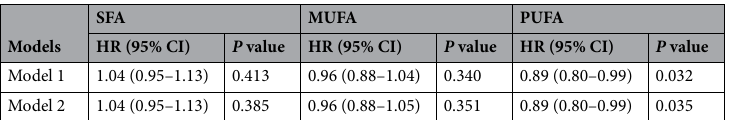
Table 4. A 5% higher calorie intake from usual intake of fatty acids and heart disease mortality risk with further adjustment for LDL cholesterol, HDL cholesterol, and triglyceride among 44,279 adults without a prior diagnosis of MI. Model 1: adjusted for age, sex, ethnicity, obesity, poverty-income ratio, education, physical activity, alcohol consumption, smoking status, survey period, usual intake of protein (natural log transformed), usual intake of carbohydrate (natural log transformed), systolic blood pressure (natural log transformed), total cholesterol (natural log transformed), and hemoglobin A 1c (natural log transformed). Model 2: adjusted for all the factors in Model 1 plus LDL cholesterol, HDL cholesterol (natural log transformed), and triglyceride (natural log transformed). CI Confidence interval, HDL High-density lipoprotein, HR Hazard ratio, LDL Low- density lipoprotein, MI Myocardial infarction, MUFA Monounsaturated fatty acid, PUFA Polyunsaturated fatty acid, SFA Saturated fatty acid.